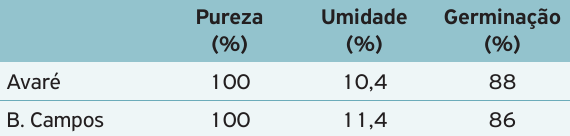
Tabela 1. Qualidade inicial de amostras de lotes de sementes de